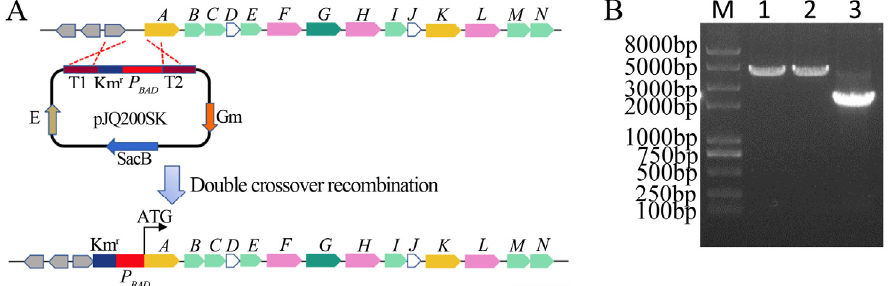
Figure 1. Construction of the ∆ P BAD -xcnA mutant strain by homologous recombination. ( A ) The process for changing the promoter of X. nematophila CB6. ( B ) Identification of the ∆ P BAD -xcnA mutant with external primers XcnA-Pro-TF/XcnA-Pro-TR, Lane M, DNA molecular marker (Direct-load StarMarker D2000 Plus II); Lane1, 2, ∆ P BAD -xcnA mutant, 4193 bp; Lane 3, wildtype, 2300 bp.